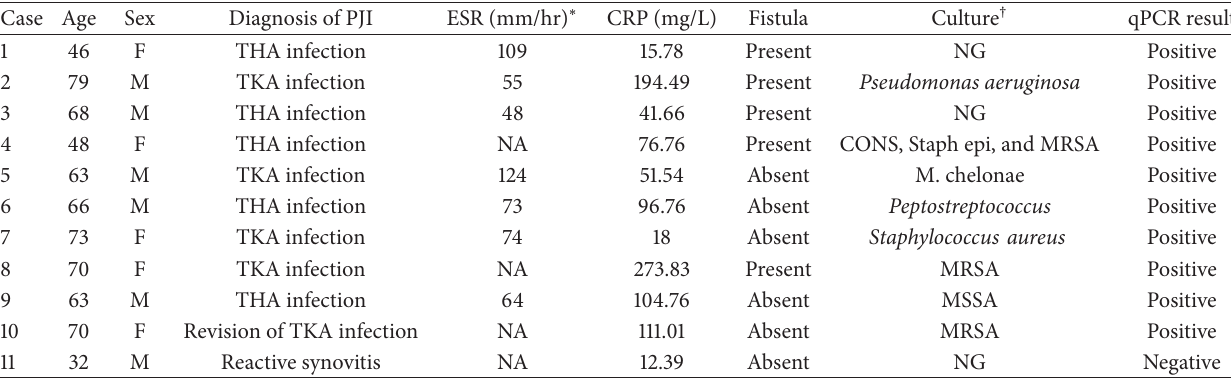
Table 1: Clinical data on patients with suspected infection